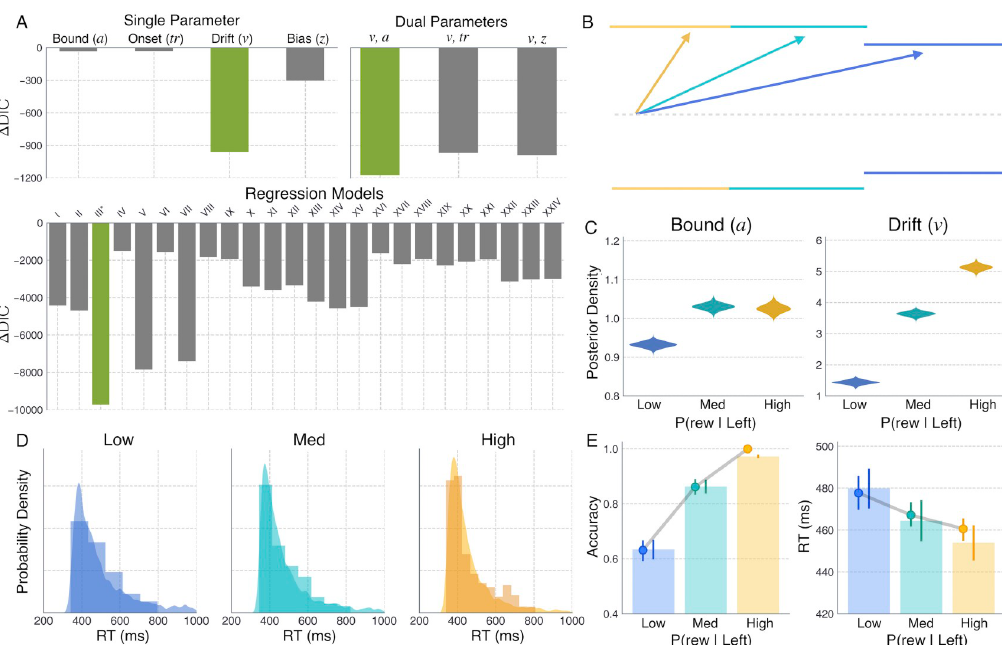
Fig 5. DDM fits to CBGT-simulated behavior reveals pathway-specific effects on drift rate and threshold mechanisms. A: Δ DIC scores, showing the relative goodness-of-fit of all single- and dual-parameter DDMs considered (top) and all DDM regression models considered (bottom) compared to that of the null model (all parameters held constant across conditions; see Table 2). The Δ DIC score of the best-fitting model at each stage is plotted in green. The best overall fit was provided by DDM regression model III. B: DDM schematic showing the change in v and a across low (blue), medium (cyan), and high (yellow) reward conditions, with the threshold for L and R represented as the upper and lower boundaries, respectively. C: Posterior distributions in each reward condition for a (Eq 1), estimated on each trial as a function of the average iMSN firing rate across left and right action channels (see I in Fig 4C), and v (Eq 2), estimated on each trial as a function of the the difference between all dMSN firing rates in the left and right channels ( D L − D R in Fig 4B). D: Histograms and kernel density estimates showing the CBGT-simulated and DDM-predicted RT distributions, respectively. E: Point plots showing the CBGT network’s average accuracy and RT across reward conditions overlaid on bars showing the DDM-predicted averages.